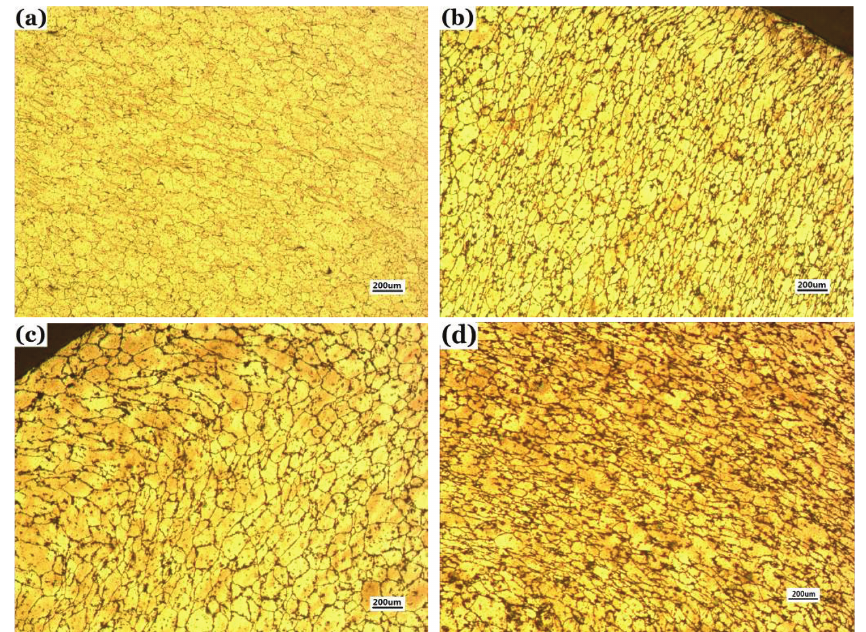
boundary after the deformation process was the high- angle boundary which was at equilibrium, and this was forming because of the dynamic recovery in the deforma- tion process. In Figure 6(b) and (c), the original grain